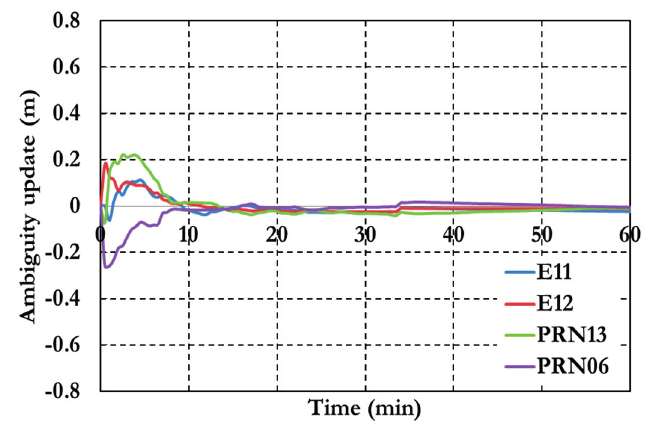
Figure 22. Positioning results of the semi-decoupled per-constellation GPS/Galileo BSSD PPP model.